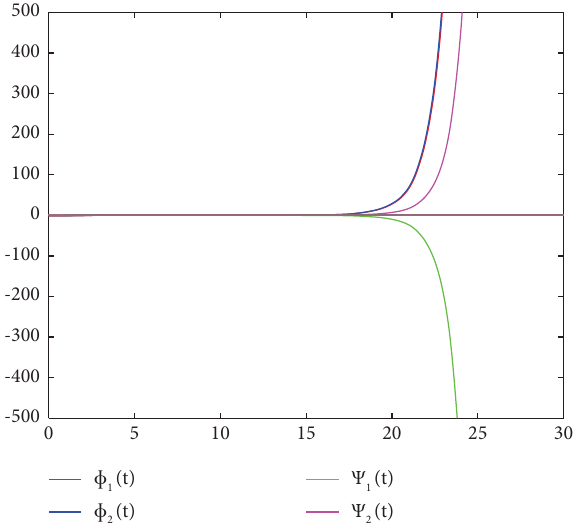
Figure 4: Te state of system (81) with T � 0 . 002, Y 􏽮 􏽯 � 2 ξ + Θ ξ